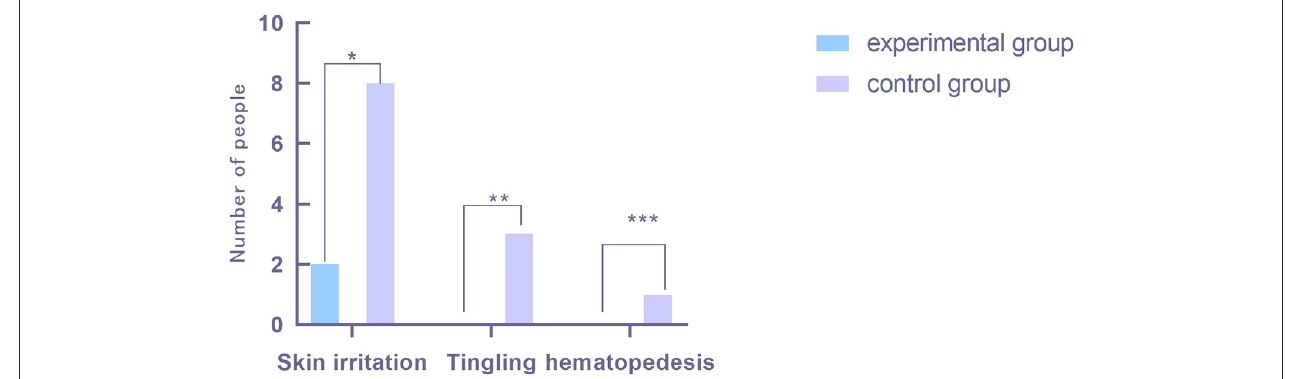
FIGURE 4 | Comparison of security influencing factors. The x -coordinate represents the factors affecting puncture safety. From left to right, it is skin redness and swelling, skin tingling, and blood oozing at puncture point. The y -coordinate represents the number of people. *There was a significant difference in the number of patients with skin redness and swelling at the puncture site between the two groups, including two patients in the experimental group and eight patients in the control group, and the difference was statistically significant ( P = 0.04). **The comparison of the number of patients with skin prickling at the puncture site between the two groups. There were no cases in the experimental group and three cases in the control group, and the difference was statistically significant ( P = 0.07). ***The comparison of the number of patients with blood exudation at the puncture site between the two groups. There were no cases in the experimental group and one case in the control group, and the results were not statistically significant ( P = 0.31).